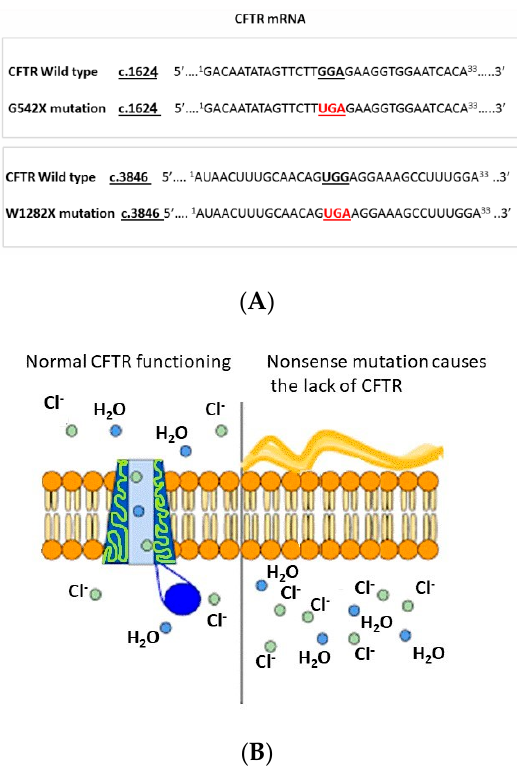
Figure 2. Illustrations of cystic fibrosis transmembrane conductance regulator (CFTR) nonsense mutations and their effect. ( A ) CFTR mRNA sequence of the stop codon G542X and W1282X (in red the PTC UGA codons). ( B ) CFTR localization and effect of the nonsense mutation on the CFTR gene, impairing cell homeostasis and causing the accumulation of mucus and the following infection.